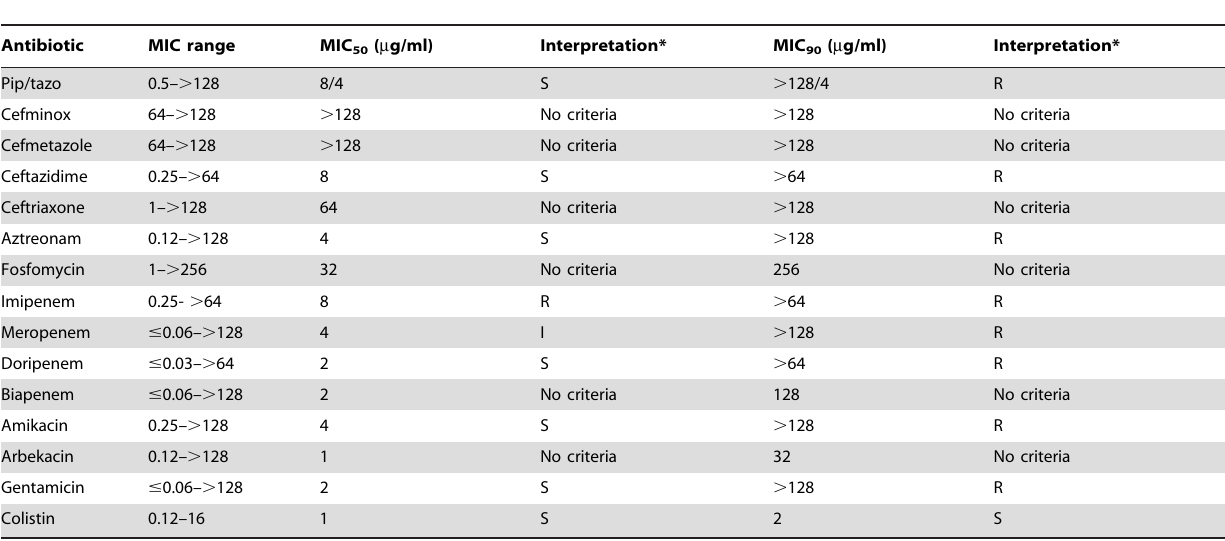
Table 4. Determination and interpretation of the MIC values of the antibiotics tested for Pseudomonas aeruginosa ** (n=153).